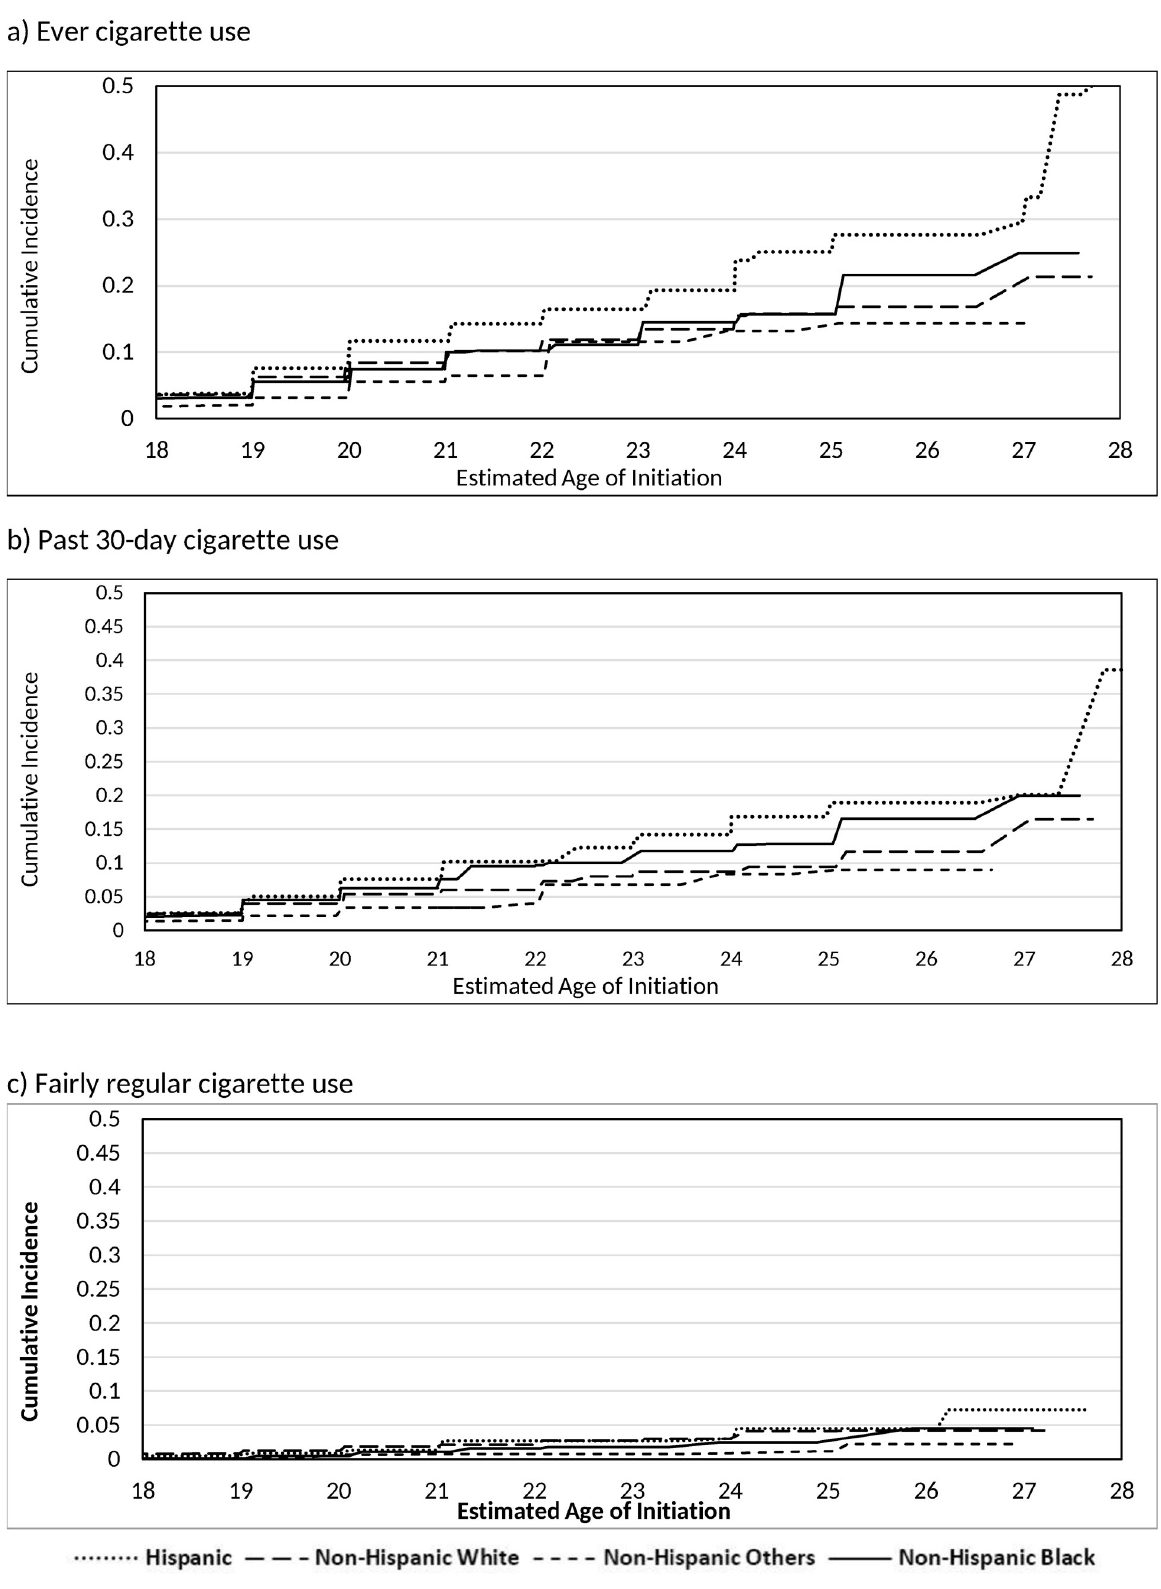
Fig 4. Estimated cumulative incidence for the age of initiation of cigarette outcomes stratified by race/ethnicity. https://doi.org/10.1371/journal.pone.0251246.g004 PLOS ONE | https://doi.org/10.1371/journal.pone.0251246 May 5,